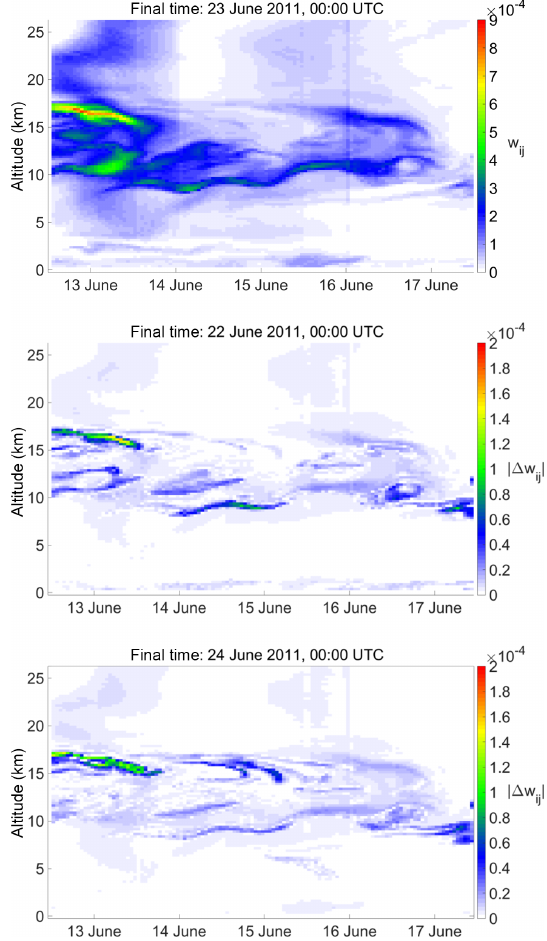
Figure 7. Sensitivity analysis for the mean rule parameter n k : esti- mated importance weights w ij for choosing 23 June, 00:00UTC as the final time of used satellite data (top); absolute differences of esti- mated importance weights | (cid:49)w ij | for choosing 23 June, 00:00UTC as the final time and those for choosing 22 June, 00:00UTC (mid- dle) and 24 June, 00:00UTC (bottom) as final